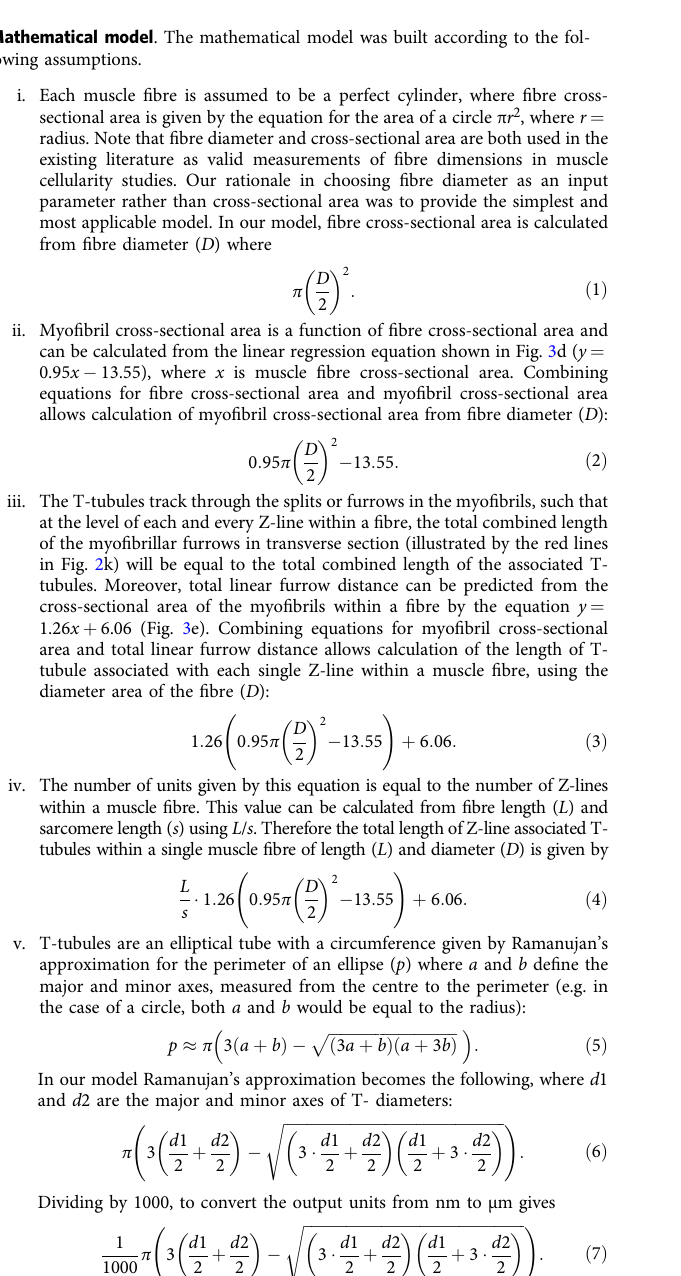
ffiffiffiffiffiffiffiffiffiffiffiffiffiffiffiffiffiffiffiffiffiffiffiffiffiffiffiffiffiffiffiffiffi 3 c þ d